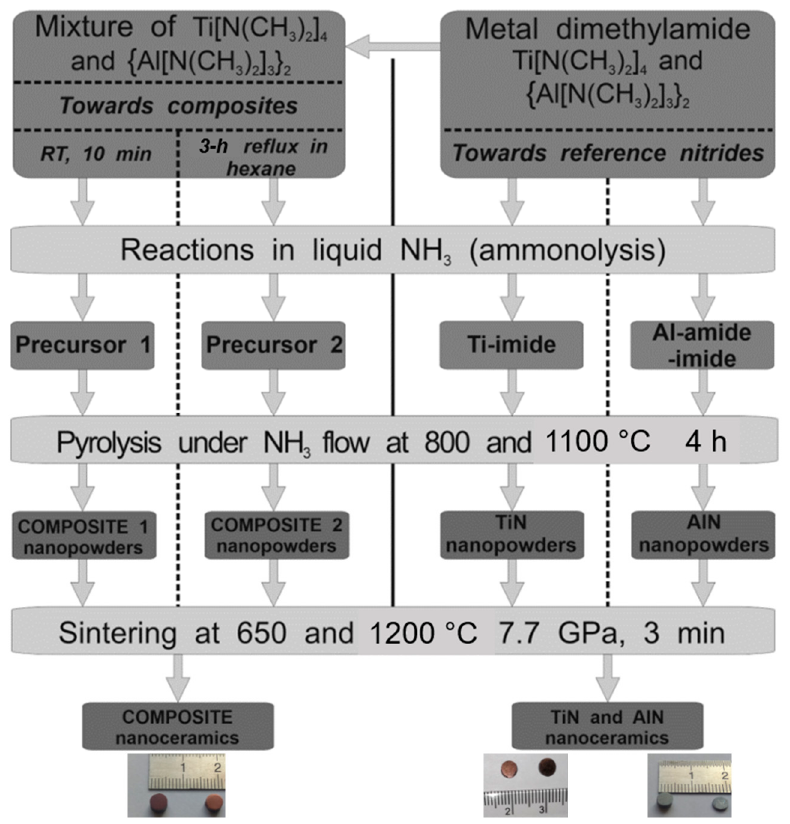
Figure 1. Schematics of experimental steps in anaerobic synthesis and subsequent high pressure and high temperature sintering of composite and individual nanopowders in the system TiN-AlN. Snapshots of typical pellets/nanoceramics are shown on the bottom as follows: ( left )—brown composite pellets; ( right )—golden-brown TiN pellets and graphite-grey AlN pellets.